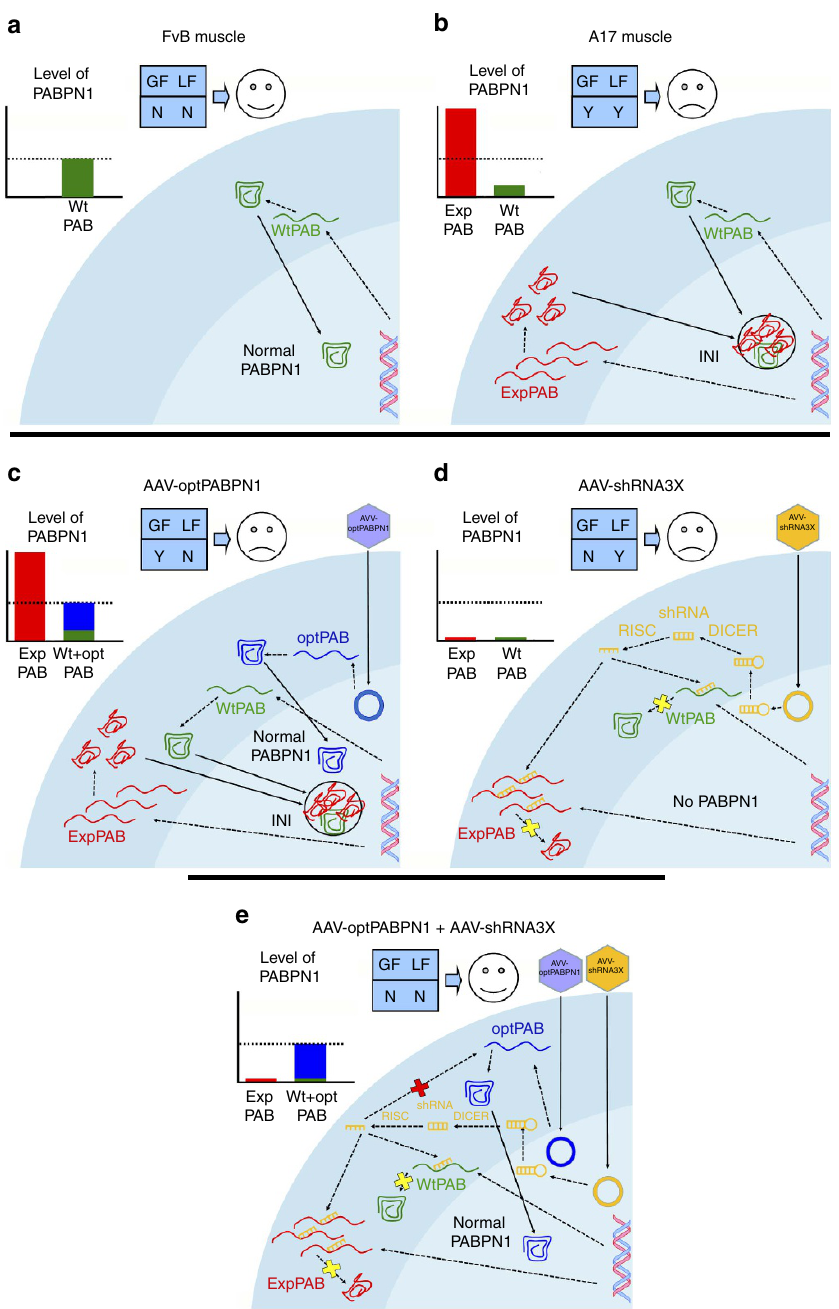
Figure 7 | The combined treatment with AAVs abrogates INIs and restores normal PABPN1 expression improving both the gain of toxic function (GF) and the loss of physiological function (LF) mechanisms of the disease in the A17 mouse model. ( a ) In wild-type FvB skeletal muscle, the endogenous wild-type PABPN1 (green) moves to the nucleus where it can function normally. The amount of normal PABPN1 that achieves the threshold for the optimal cell survival and functionality as shown in the graph in the upper left side. There is no loss of function (LF) or gain of function (GF), labelled with N (Not). ( b ) In A17 mice the expression of expPABPN1 (red) induces aggregate formation where normal PABPN1 and several other proteins as well as polyA RNAs are trapped. This might respectively induce both a loss of function (LF) associated to a minor amount of normal PABPN1 available and a toxic gain of function (GF) due to the sequestration of other macromolecules associated to dysregulated biological pathways, labelled as Y (Yes). ( c ) After injection of AAV-optPABPN1, the newly expressed optPABPN1 (blue) counteracts the lack of available normal PABPN1 (that is, it may reduce the loss of function mechanism of the disease) but it does not affect aggregate formation nor the toxic gain of function mechanism. No improvement of the pathology is observed. ( d ) By delivering ddRNAi to knockdown endogenous PABPN1, and after its conversion to siRNA by DICER and RISC complexes, aggregates are abrogated and this is likely associated to a reduction on the gain-of-function mechanism. However the normal PABPN1 downregulation promotes muscle degeneration. Again, no improvement of the pathology is observed. ( e ) Only the co-injection of the two vectors inhibits the aggregate formation while rescuing the normal PABPN1 to the level vital for optimal cell survival and functionality in A17 muscles (suggesting that both the toxic gain of function and the loss of function effect might be significantly